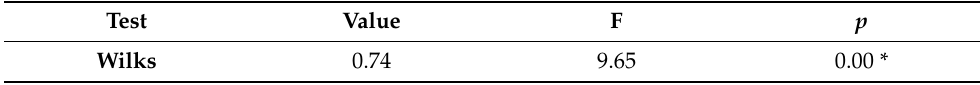
Table 3. Result of ANOVA for repeated measures (for groups). Test Value F p Wilks 0.74